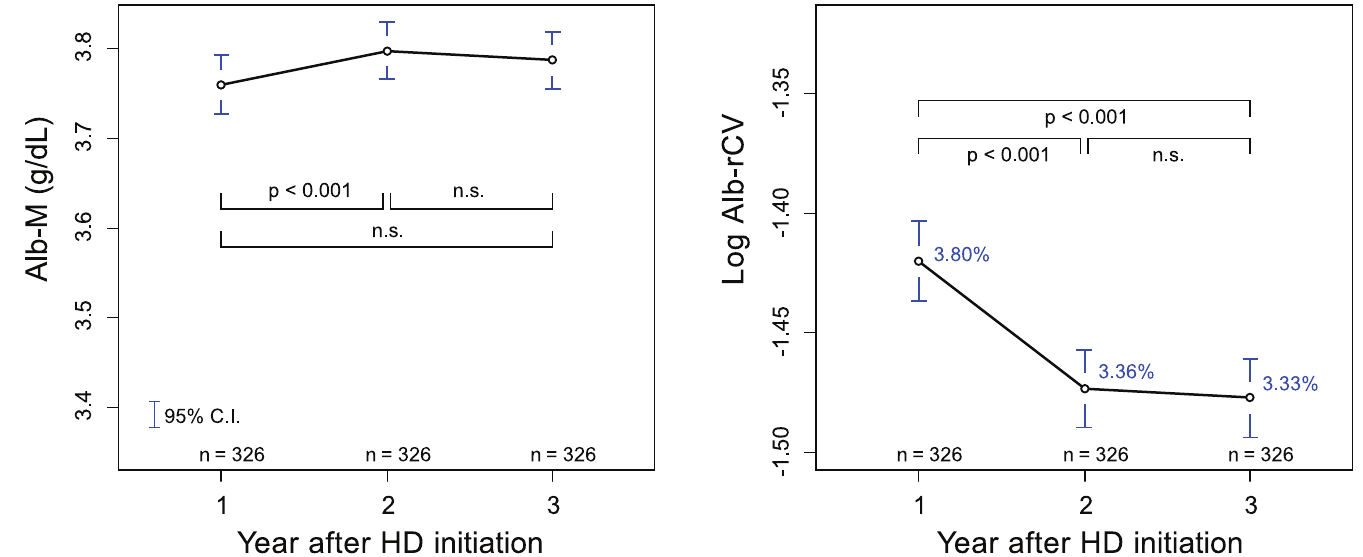
Fig 8. Annual comparison of Alb-M and Alb-rCV levels for the first 3 years after HD initiation. Among the post-HD initiationsubcohort, 326 subjects who survived and continuedto receiveHD treatment at one of the study facilities for more than 3 years were selected. The mean Alb-M or log Alb-rCV values were then comparedfor the years after HD initiationusing pairwisedependent t-test with Holm’s adjustment. The percentages written in blue are rCV values equivalentto a mean log Alb-rCV.